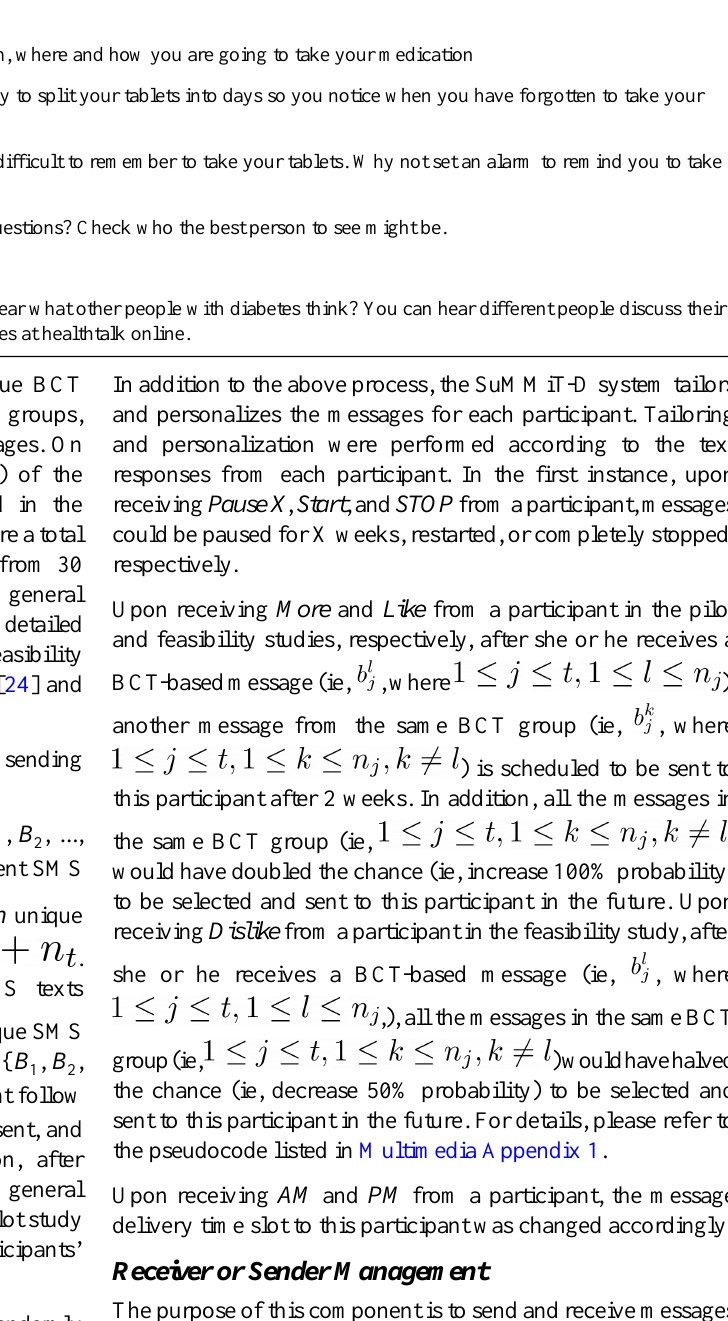
Table 2. Examples of SMS text messages used in the Support through Mobile Messaging and Digital Health Technology for Diabetes feasibility study. Example messagesMessage